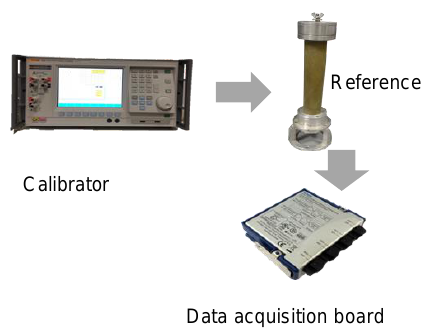
Figure 2. Simple schematic of the setup adopted for the reference divider characterization.